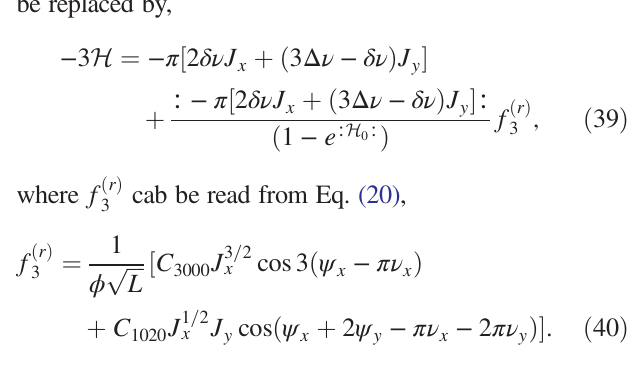
FIG. 16. A set of invariant tori in the nonlinear normalized 4D phase spaces near the difference resonance: ν 0 . 314 . The red dots represent the transformed periodic orbits from tracking and the blue lines are the special solutions of the and ν y ¼ Hamiltonian in Eq.